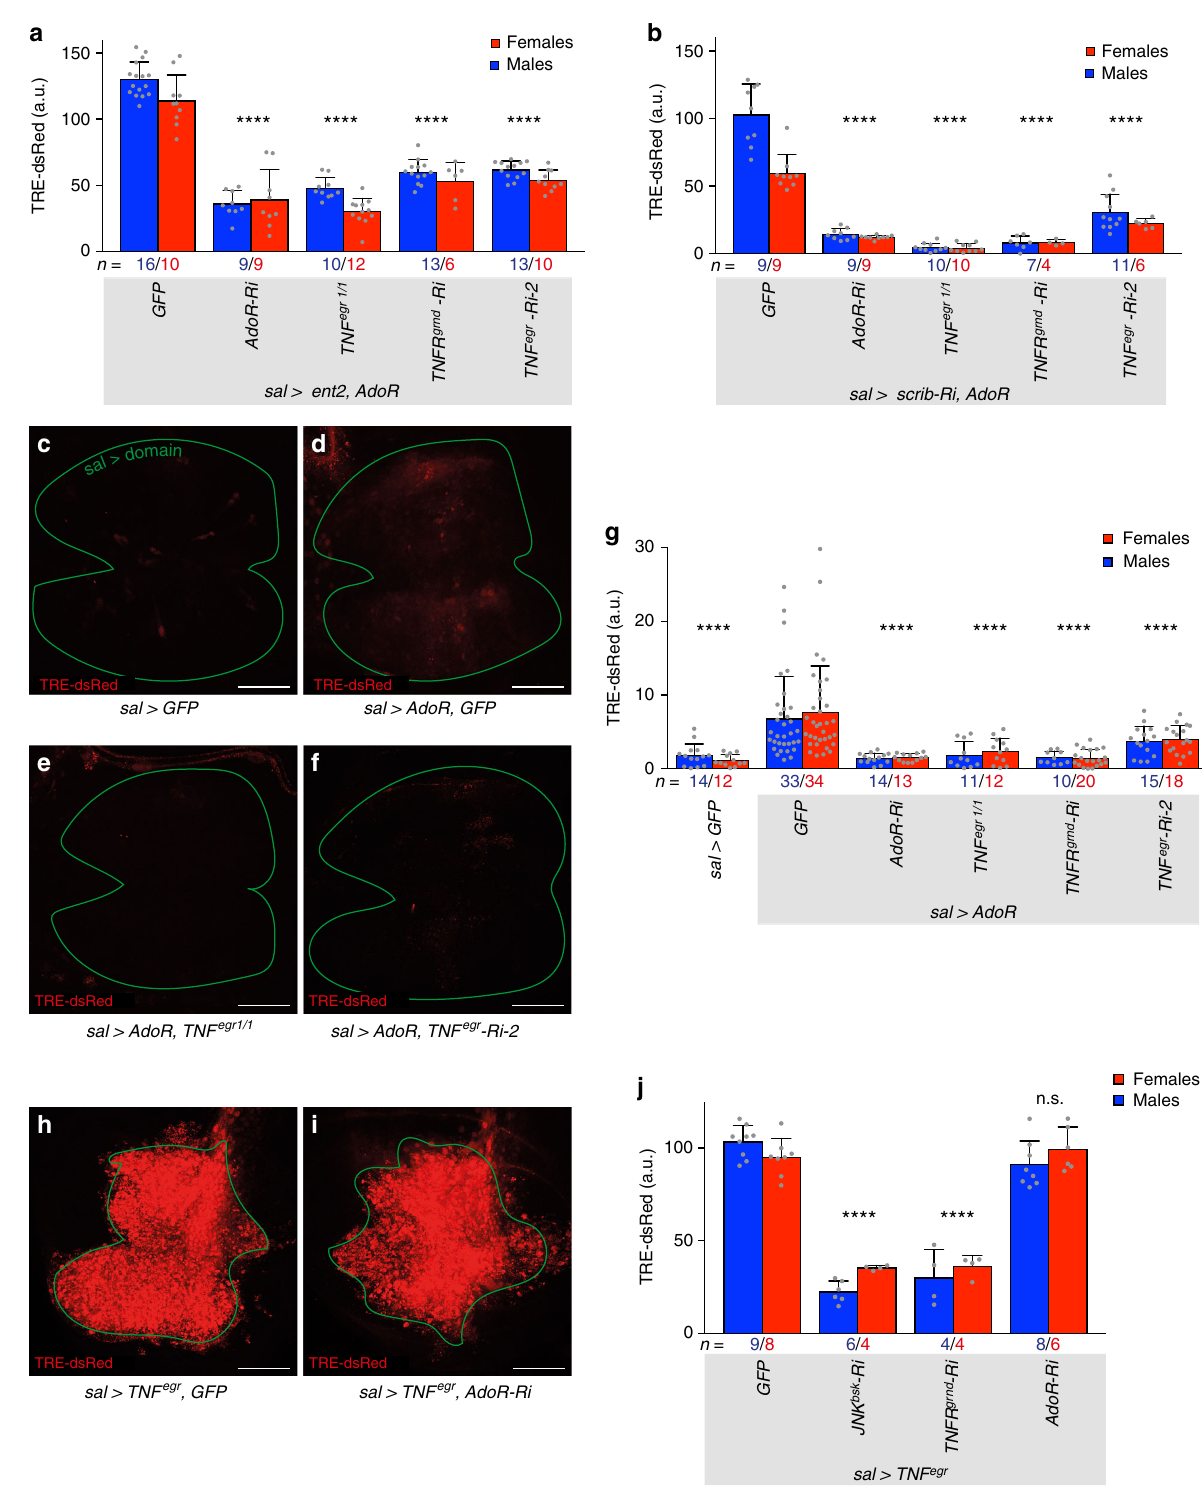
Fig. 3 AdoR acts upstream of TNF Egr during chronic polarity stress. a , b Activation of TRE-dsRed in sal > ent2, AdoR or in sal > scrib-Ri, AdoR discs is suppressed by expression of AdoR -RNAi, mutation in TNF egr , expression of TNFR grnd -RNAi or expression of TNF egr -RNAi. c – g Mild activation of TRE-dsRed caused by overexpression of AdoR alone is rescued by AdoR -RNAi, in a TNF egr mutant background, by TNFR grnd -RNAi or by TNF egr -RNAi. h – j TRE-dsRed activation triggered by overexpression of TNF Egr is suppressed by JNK bsk -RNAi or TNFR grnd -RNAi but is not affected by AdoR -RNAi. This experiment was carried out at 29 °C. Scale bars, 50 μ m. In graphs, means are shown, and error bars represent ±SD; **** P < 0.0001, n.s. P ≥ 0.05, unpaired two-tailed Student ’ s t -test (males and females pooled